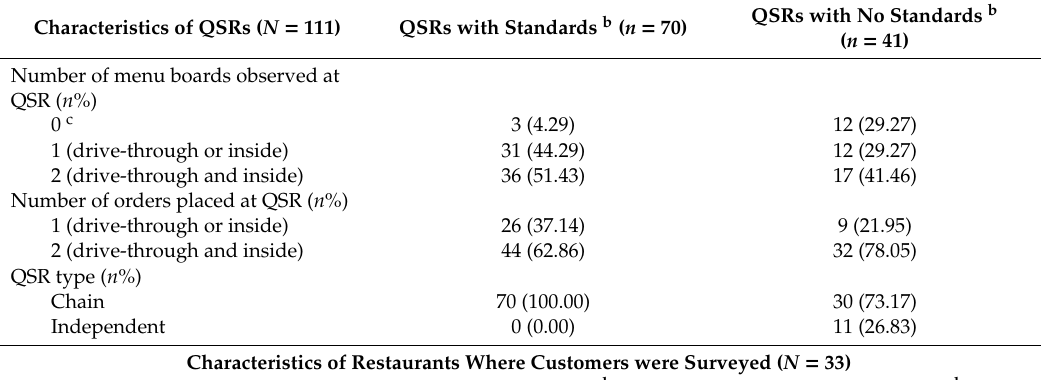
Table 1. Characteristics of sampled quick-service restaurants (QSRs), customer survey respondents and accompanying children a